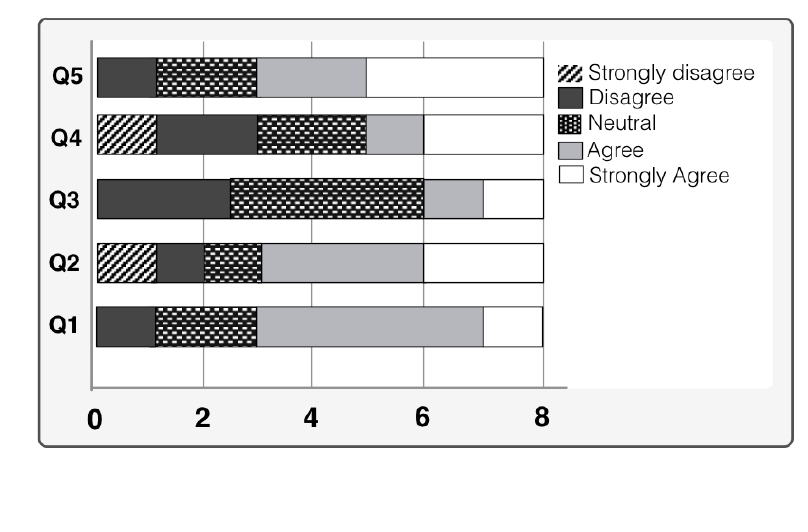
Table 7. Questions: (For old